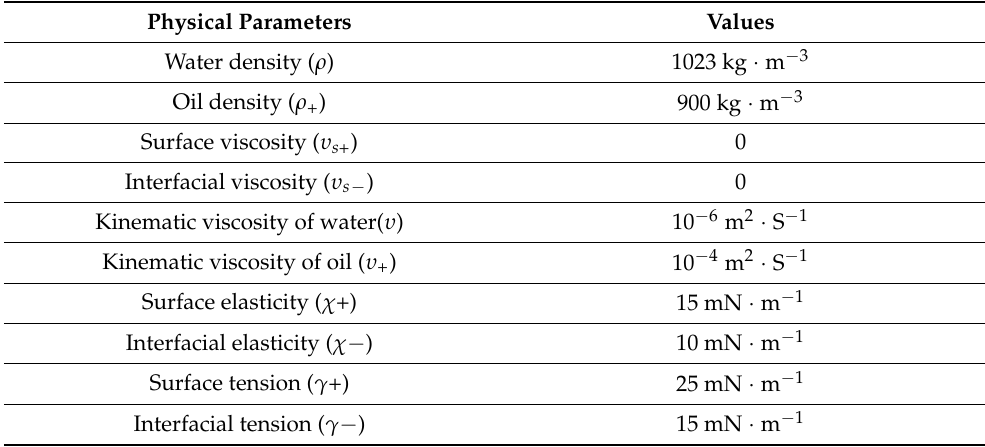
Table 1. Relevant parameters of oil spill (see